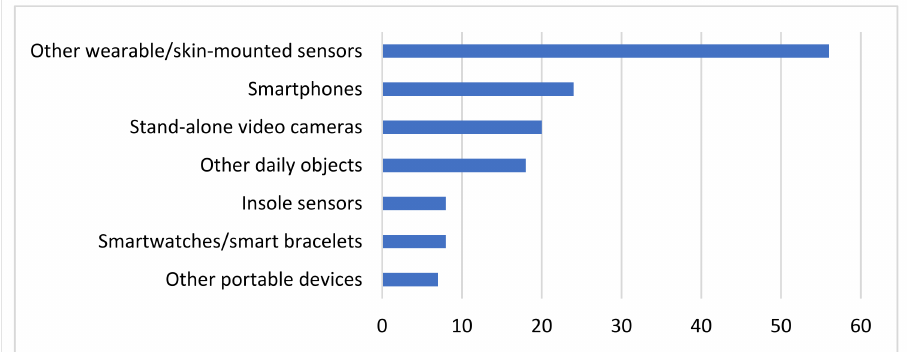
Figure 4. Distribution of different devices deployed over the considered